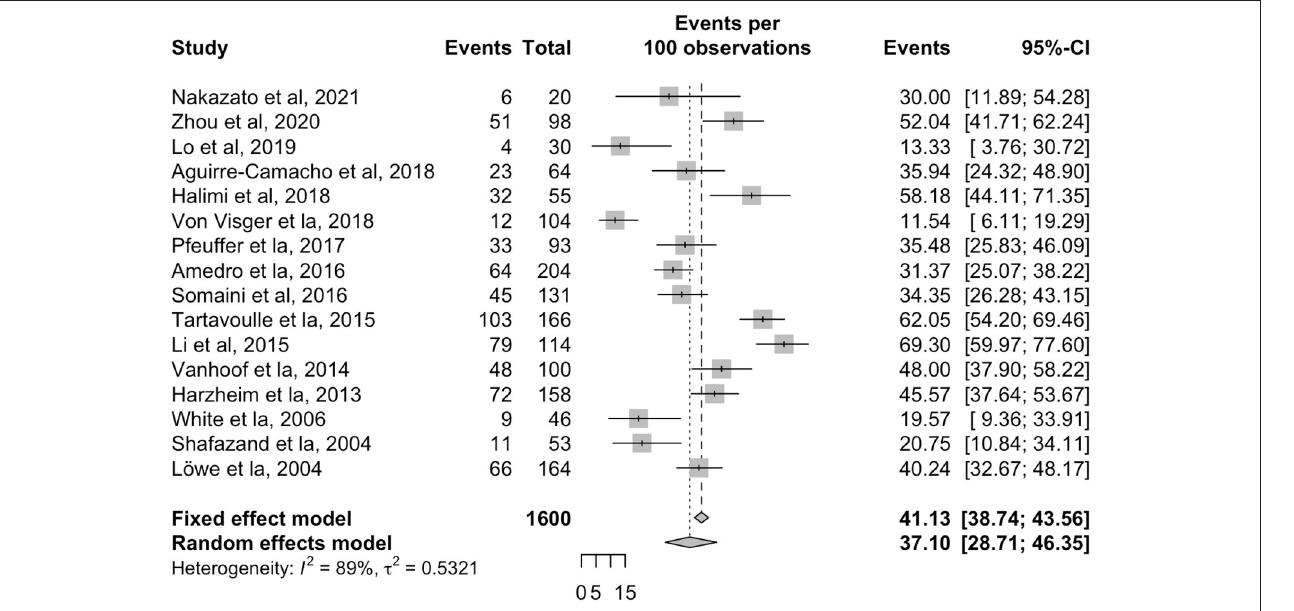
FIGURE 3 | Forest plot for the pooled prevalence of anxiety in patients with pulmonary hypertension.